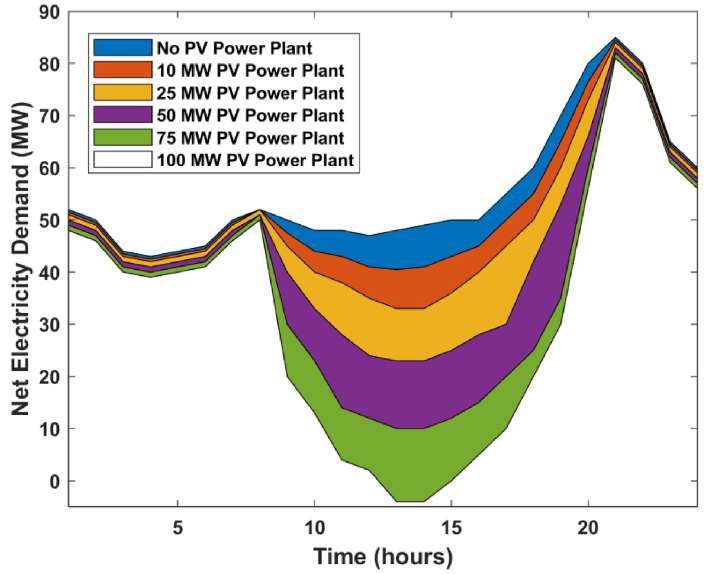
Figure 1. Duck-curve